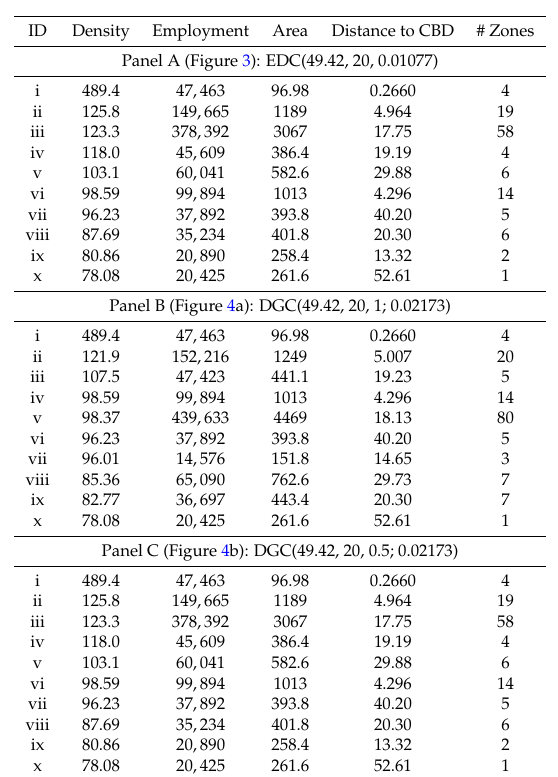
Table A2. Los Angeles Metropolitan Area subcenters. Density = employees per hectare; area = hectares; distance to CBD = kilometers; and # zones indicate TAZ units; IDs link subcenters to their location in respective figures; Subcenters are ordered according by subcenter employment density. The same applies to Table A3 to A4. EDC, exponentially declining cutoff; DGC, density-gradient-related cutoff.